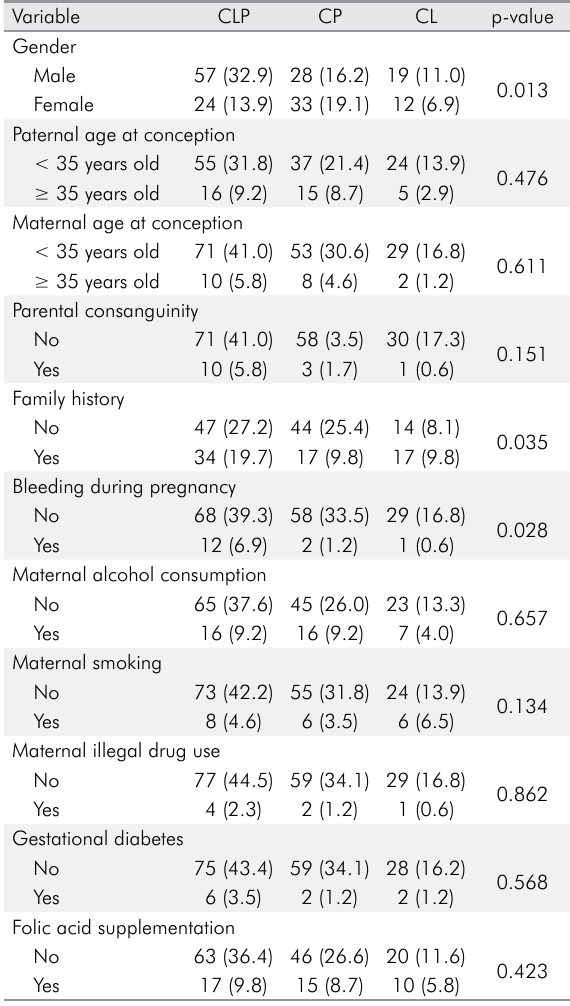
Table 4. Obstetric history and birth characteristics of studied patients. Table 5. Risk factors according to cleft